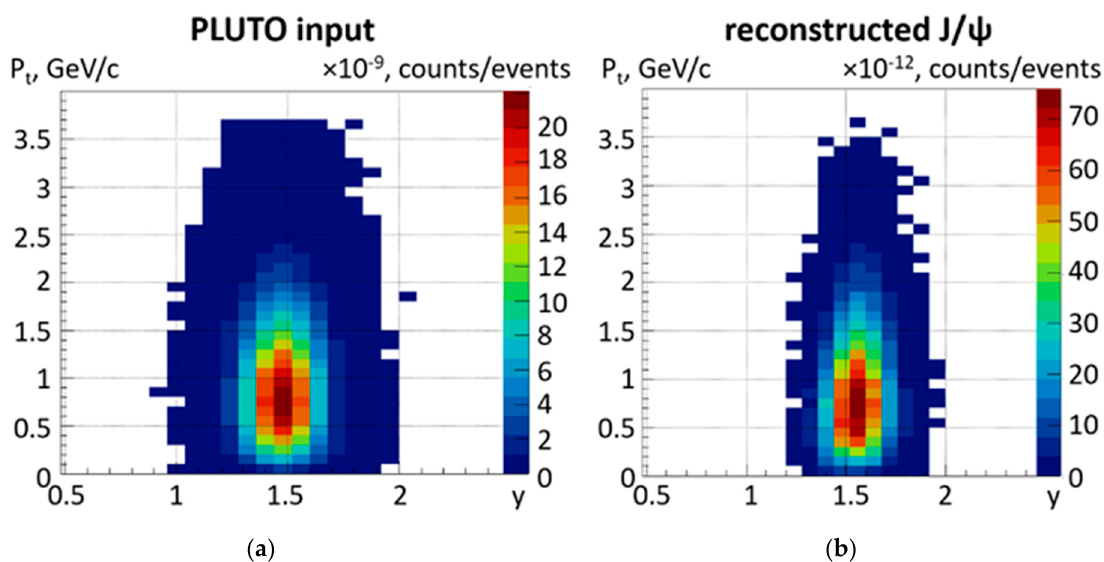
Figure 9. ( a ) J/ ψ meson simulation input in the plane transverse momentum versus rapidity for central Au + Au collisions at 8 A GeV/c. ( b ) Corresponding reconstructed J/ ψ meson distribution.